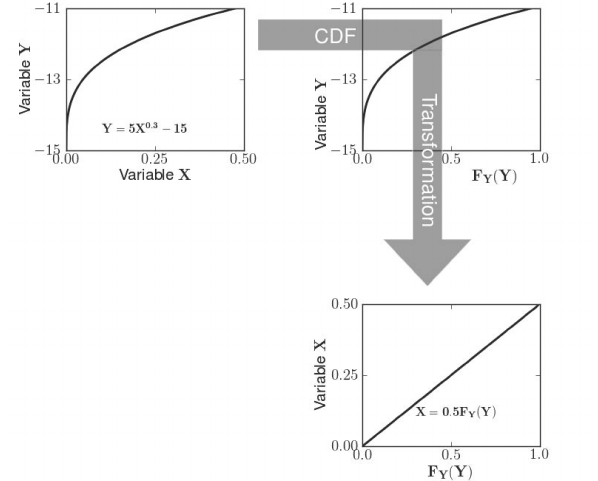
Figure 3. Transformation of monotonically increasing nonlinear function to linear function using the CDF transformation. Here X represents the SM, Y corresponds to backscatter ( Y ) is the CDF transformed backscatter coefficient, and F Y